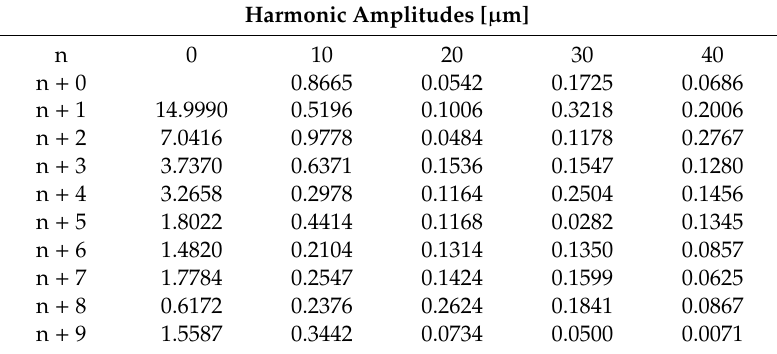
Table 8. Amplitudes of harmonic components for the profile obtained by superimposing the measured roundness profile of journal no. 5 on the profile of the eccentric movement of the center of the measured roundness profile when the supports are set at the same height ( x = 0 mm); with an eccentricity of the main journal e = 0.03 mm.